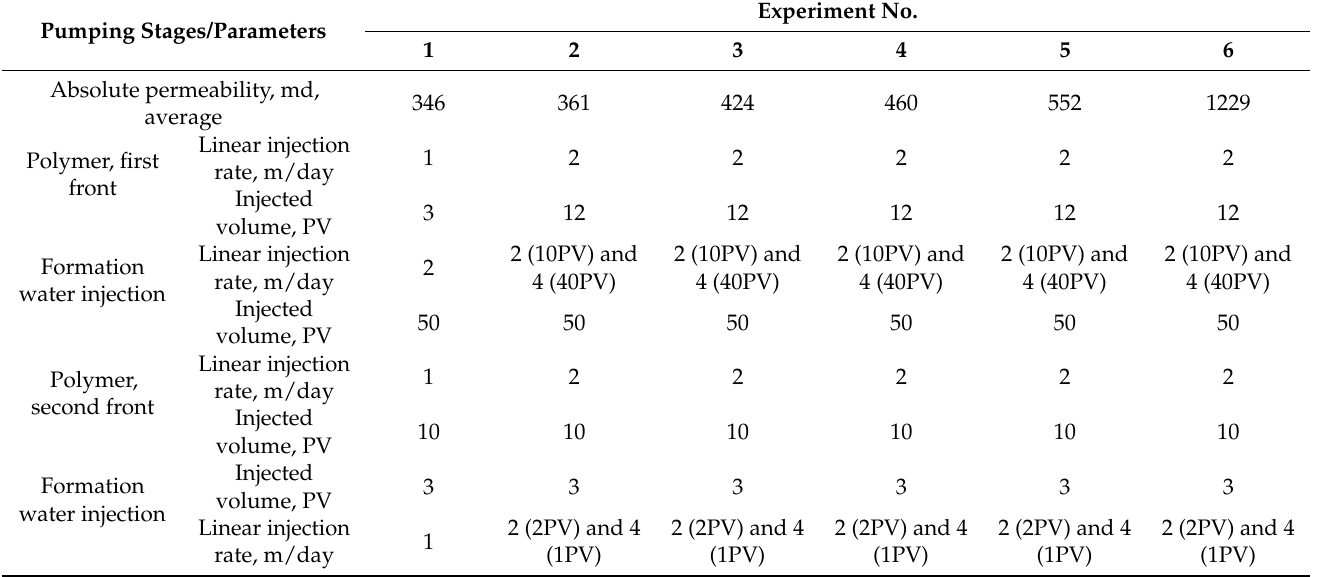
Table 4. Slug volumes and injection rates for determination of retention using the dynamic 2-fronts method. The sequence is reproduced in the table, following the 2-fronts method described in Figure 2. The first line details the permeability of the samples. The second line summarizes the parameter for the first polymer + tracer front. The third line summarizes the parameter for the water flush between both fronts (experiments no. 2–6 has 2 rates in water injection, the first rate 2 m/day during 10 pore volumes, and the second rate 4 m/day during 40 pore volume). The fourth line details the injection parameters for the second polymer + tracer front. The last line details the parameters for the final water clean-up (experiments no. 2–6 has 2 rates in water injection, the first rate 2 m/day during 2 pore volumes, and the second rate 4 m/day during 1 pore